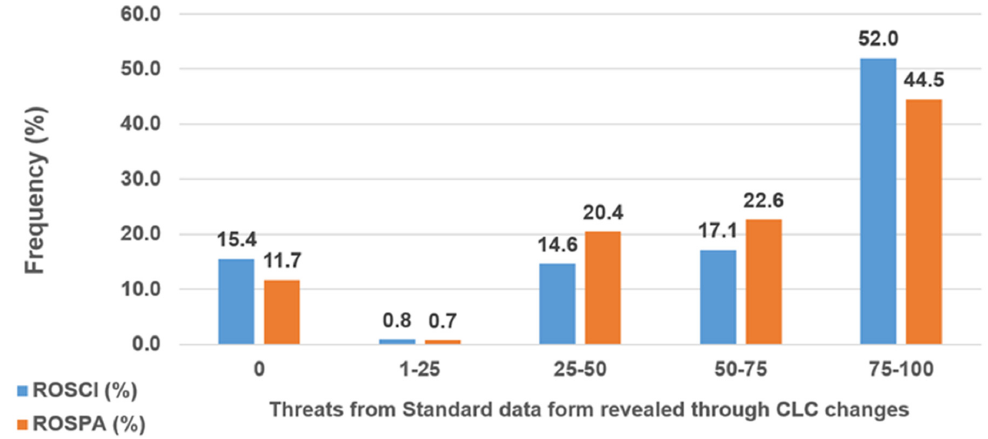
Figure 17. Frequency distribution of threats from Standard data form revealed by CLC changes.